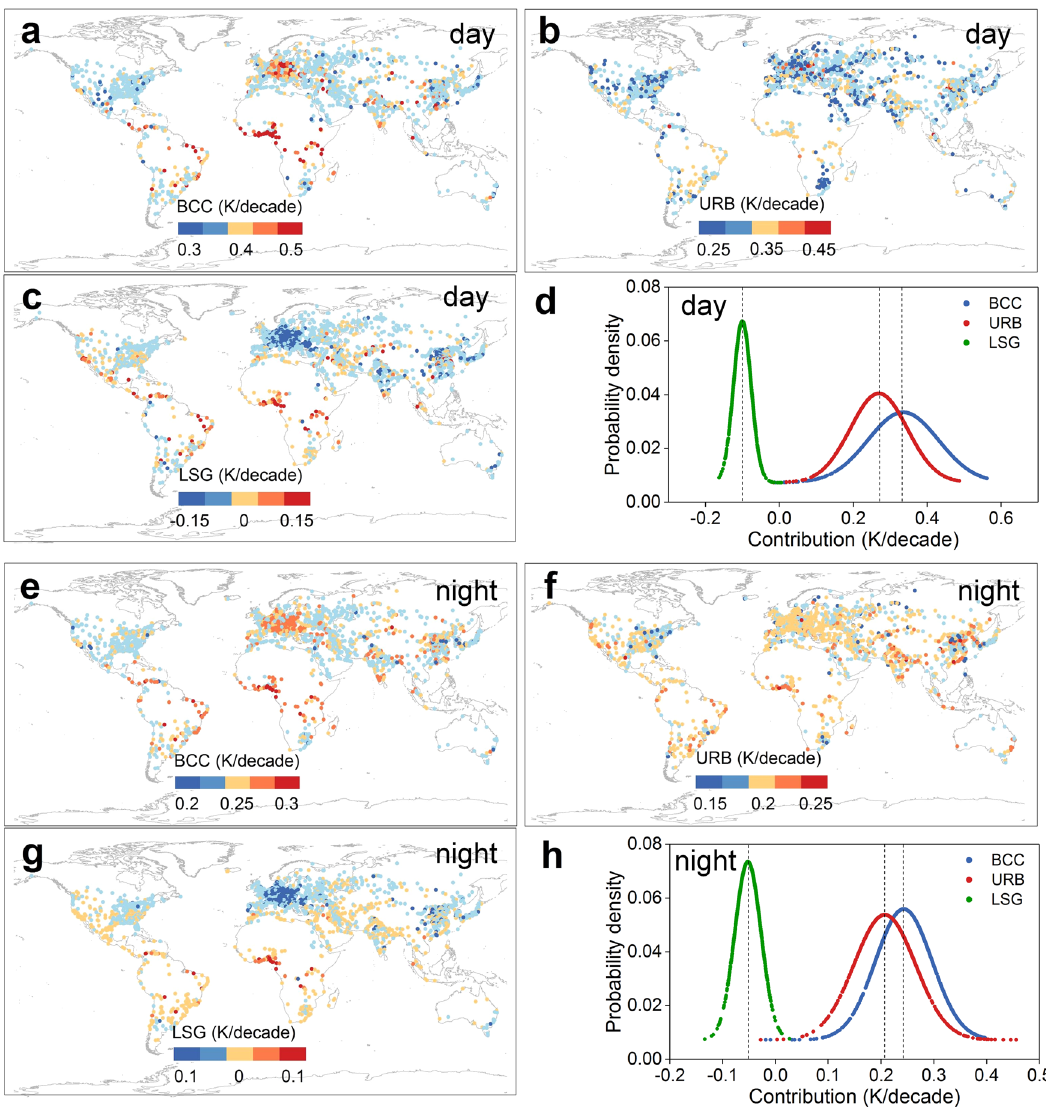
Fig. 4 Separate contributions (K decade − 1 ) of background climate change (BCC), urbanization (URB), and landscape greening (LSG) to urban surface warming trends. Map of daytime for BCC, URB, and LSG ( a – c ), map of nighttime for BCC, URB, and LSG ( e – g ), and probability density distribution of the separate contributions for daytime ( d ) and nighttime ( h